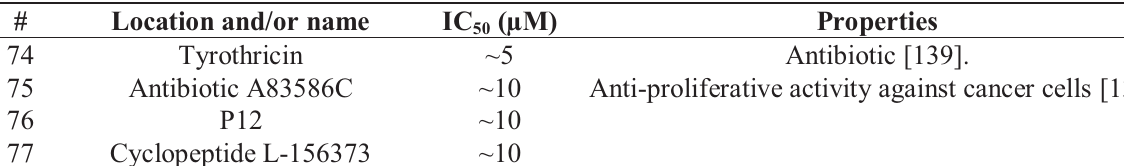
Table 8. Cyclic peptides.